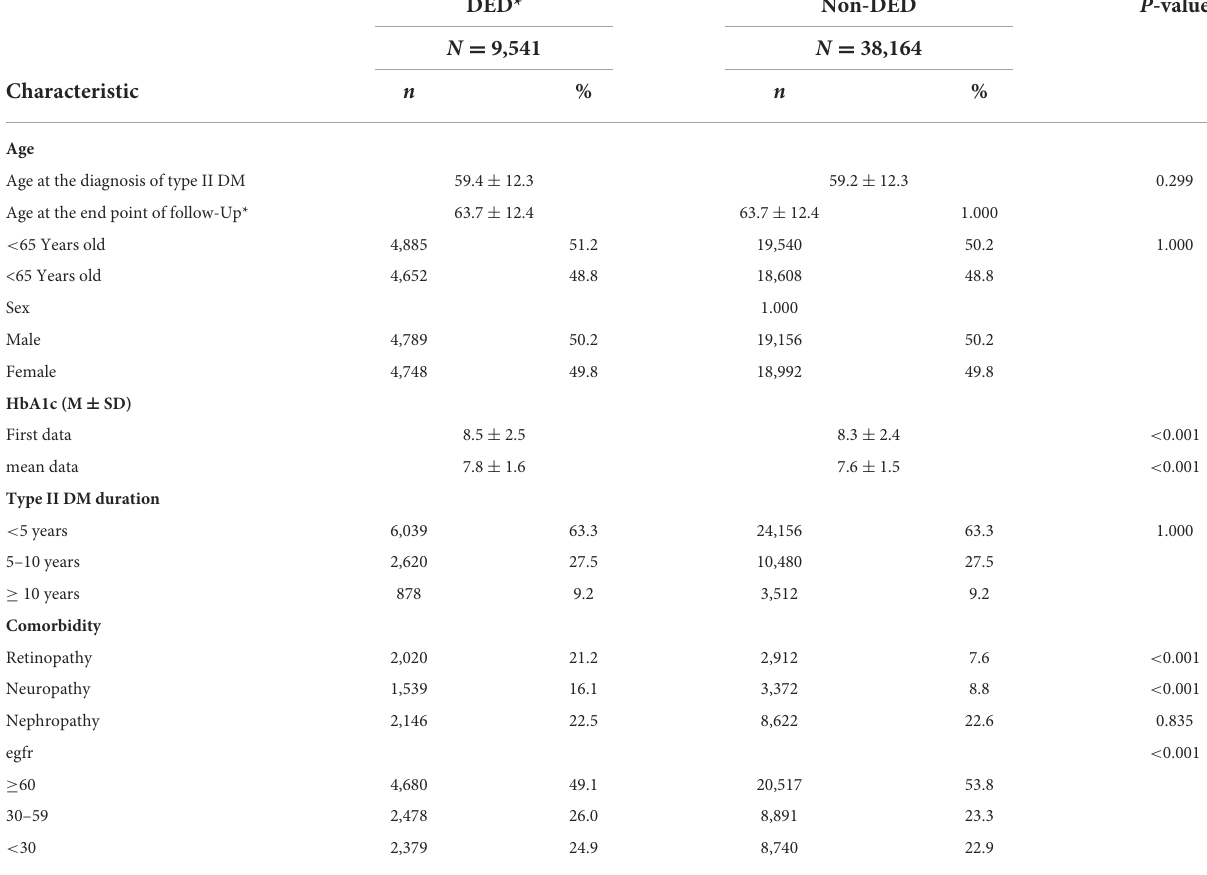
TABLE 2 Demographics and characteristics of the dry eye disease and non-dry eye disease groups in patients with type II diabetes mellitus after age and sex match. DED* Non-DED P -value N = 9,541 N =